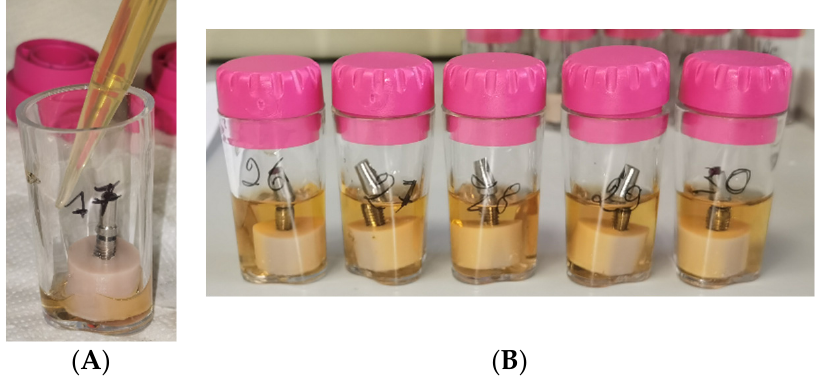
Figure 9. ( A ) Placing of specimens in sterile tubes and nutrient solution; ( B ) Closure of tubes with cap.